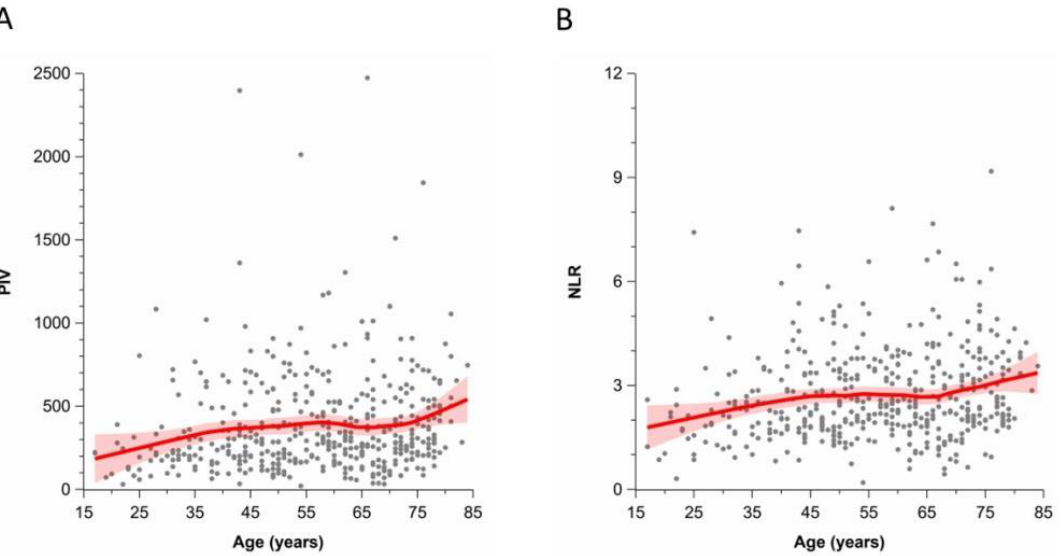
Figure 2. Association between age at diagnosis of patients with cutaneous melanoma and the pan- immune inflammation value (PIV, ( A )) and the neutrophil-to-lymphocyte ratio (NLR, ( B )) (Spearman rank correlation coefficient 0.17 (95%CI 0.08–0.26) and 0.18 (95%CI 0.09–0.27), respectively); red bands indicate 95% confidence interval bands.